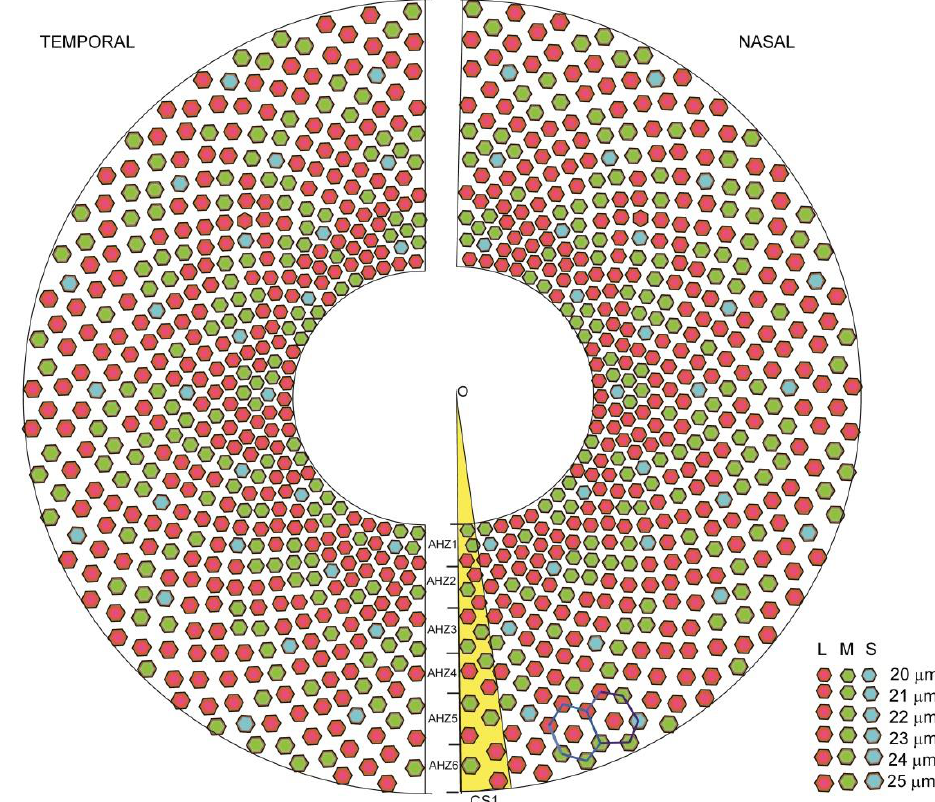
Figure 7. The organization pixel mosaic in FAZ. The FAZ zone in the artificial human macula (AHM) is composed by two hemipseudospheres first, the hemipseudosphere generated like in Figure 6 represents the nasal part of the retina and the other hemipseudosphere is the mirror imagine of the first one, being the temporal part of the retina. Each hemipseudosphere contains 486 pixels in 2 × 3 panels such that the each half pseudosphere contains 486 pixels organized in 2 × 3 panels, such that the entire prosthesis hosts 972 pixels. Each two adjacent circular trapezes determines a hexagonal arrangement of pixels marked by hexagons with gray lines. The first circular surface is marked in yellow. This plot has been obtained in Microsoft Excel 2010 by a routine implementing the method described in the text. S, M and L cone cell sensitivity is represented by the corresponding colors: red (620–750 nm), green (500–570 nm) and blue (450–500 nm), respectively.